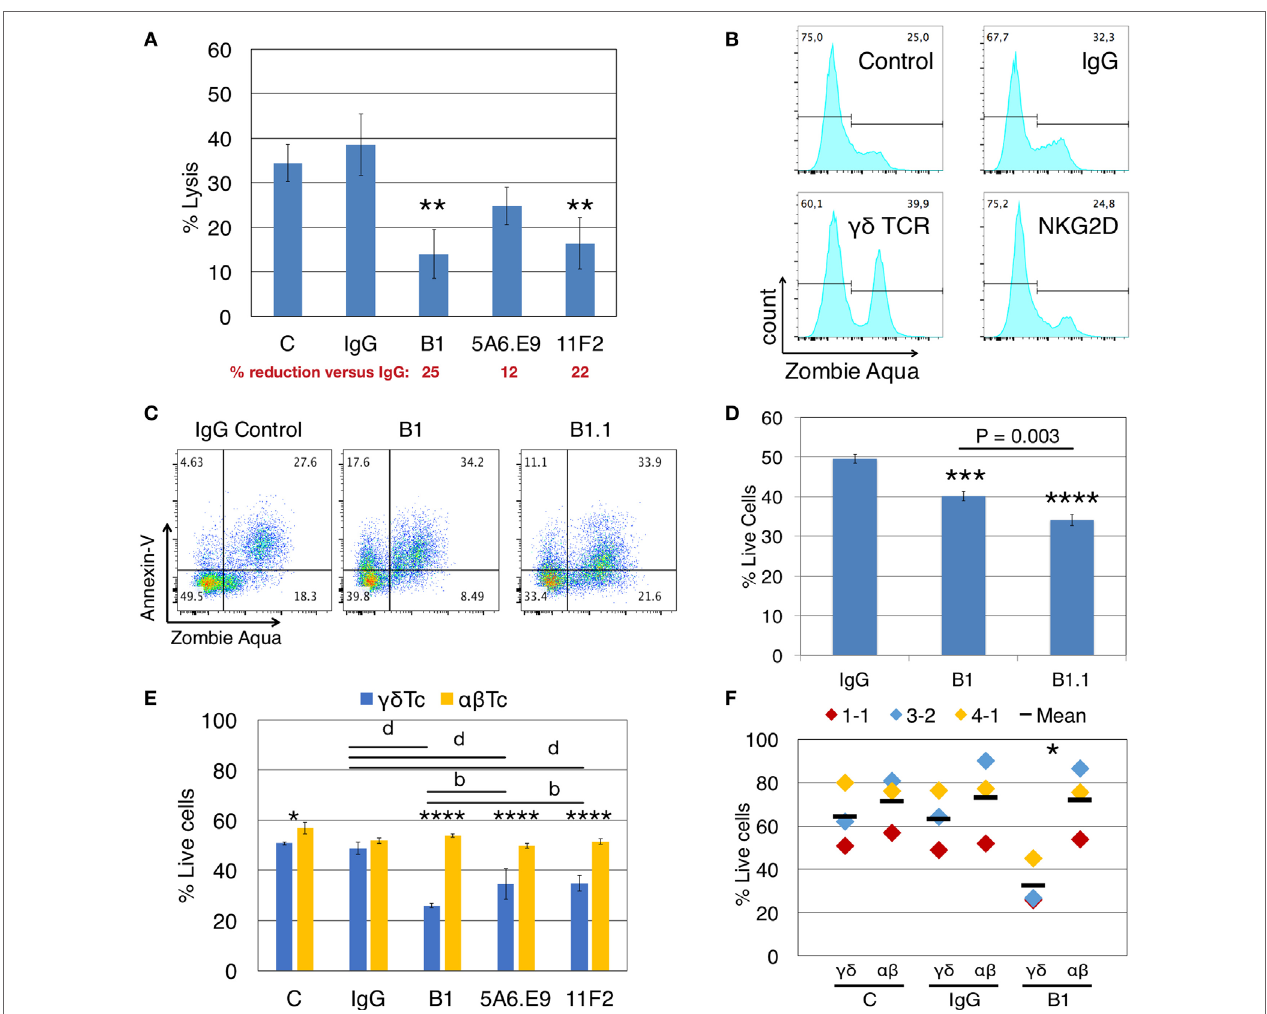
FigUre 1 | Anti- γδ TCR antibodies reduce lysis of breast cancer cells concomitant with γδ T cell death. (a) Donor 1 day 21 primary human γδ T cells were preincubated for 30 min with (1 μ g/well) or without antibodies (C = control), then incubated with calcein AM-labeled T47D targets in triplicate at a 20:1 effector:target (E:T) ratio for 4 h. A significant reduction in % lysis was observed in the presence of anti- γδ TCR antibodies. Percent reduction compared to IgG (red font) was calculated: 100 − (% lysis or live cells treated with antibody/IgG × 100). (B) Representative example showing that treatment of 600,000 Donor 2 day 14 γδ T cells for 4.5 h with 1 μ g antibody alone induces cell death as evidenced by Zombie Aqua Viability dye uptake. (c) Representative example indicates induction of apoptosis in Donor 3 day 21 γδ T cells via antibody treatment as in panel (B) . (D) Summary of results from experiment shown in panel ( c) . (e) Treatment of Donor 1 αβ T cells with anti-TCR γδ antibodies does not cause cell death. (F) Compiled results for three independent experiments, focusing on B1 versus IgG. Error bars indicate SD ( n = 3); significant differences compared to IgG controls (a,D) or between αβ and γδ T cells (e,F) were determined by one-way (a,D) or two-way (e,F) ANOVA followed by Bonferroni’s multiple comparisons test (* P < 0.05, ** P < 0.01, *** P < 0.001, **** P < 0.0001; b P < 0.01, d P <